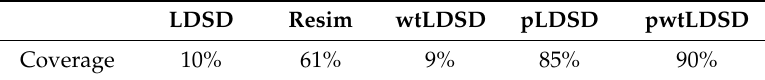
Table 2. The coverage of the propagated approaches vs.